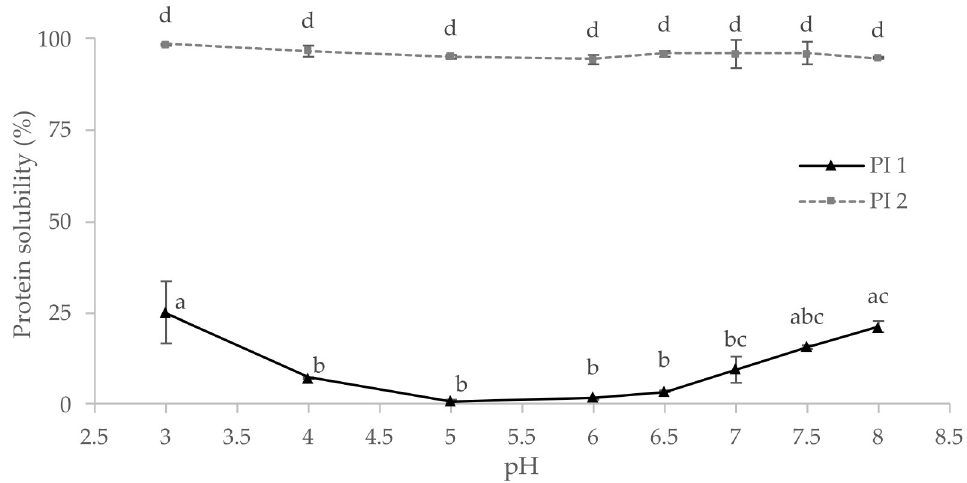
Figure 2. Protein solubility of the protein isolates PI 1 and PI 2 at different pH values; same letters indicate no significant differences ( p < 0.05).